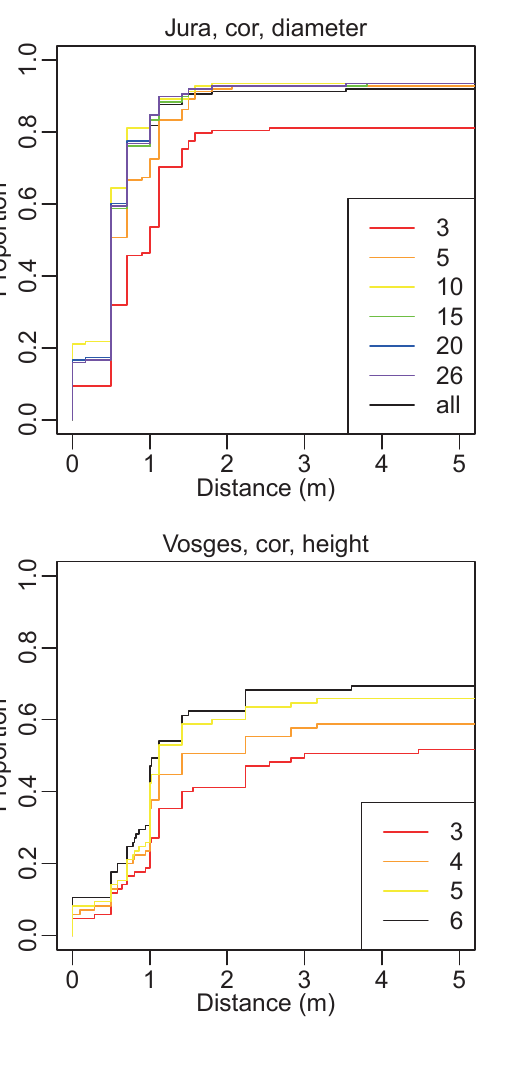
Figure 5. Cumulative proportion of validated plots as a function of the distance between the operator position and the algorithm position. Line colors refer to the sample size. Subfigure titles refer to the study area, the method used ( cor correlation or wmae weighted mean absolute error) and the input tree variable (diameter or